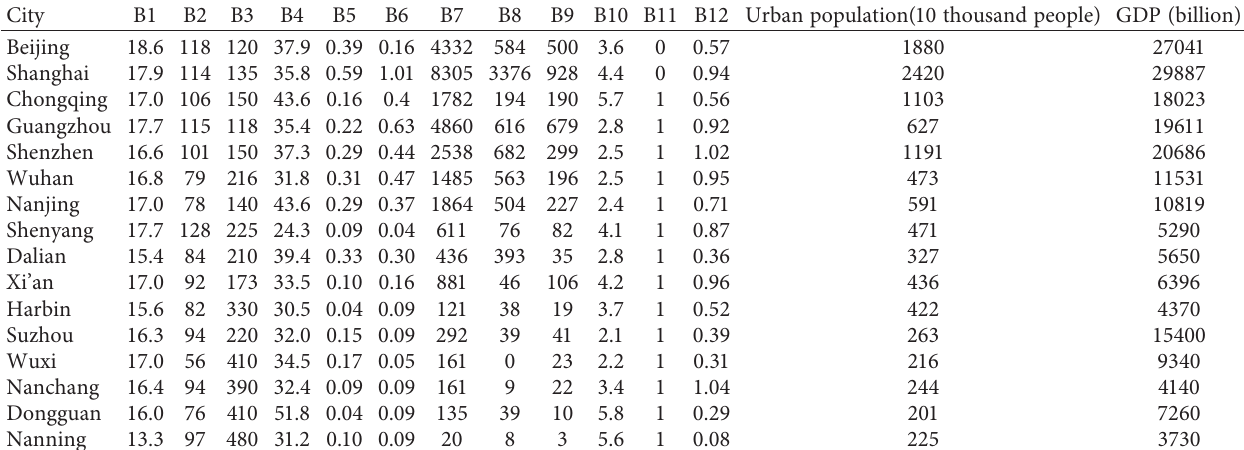
Table 2: Original data.